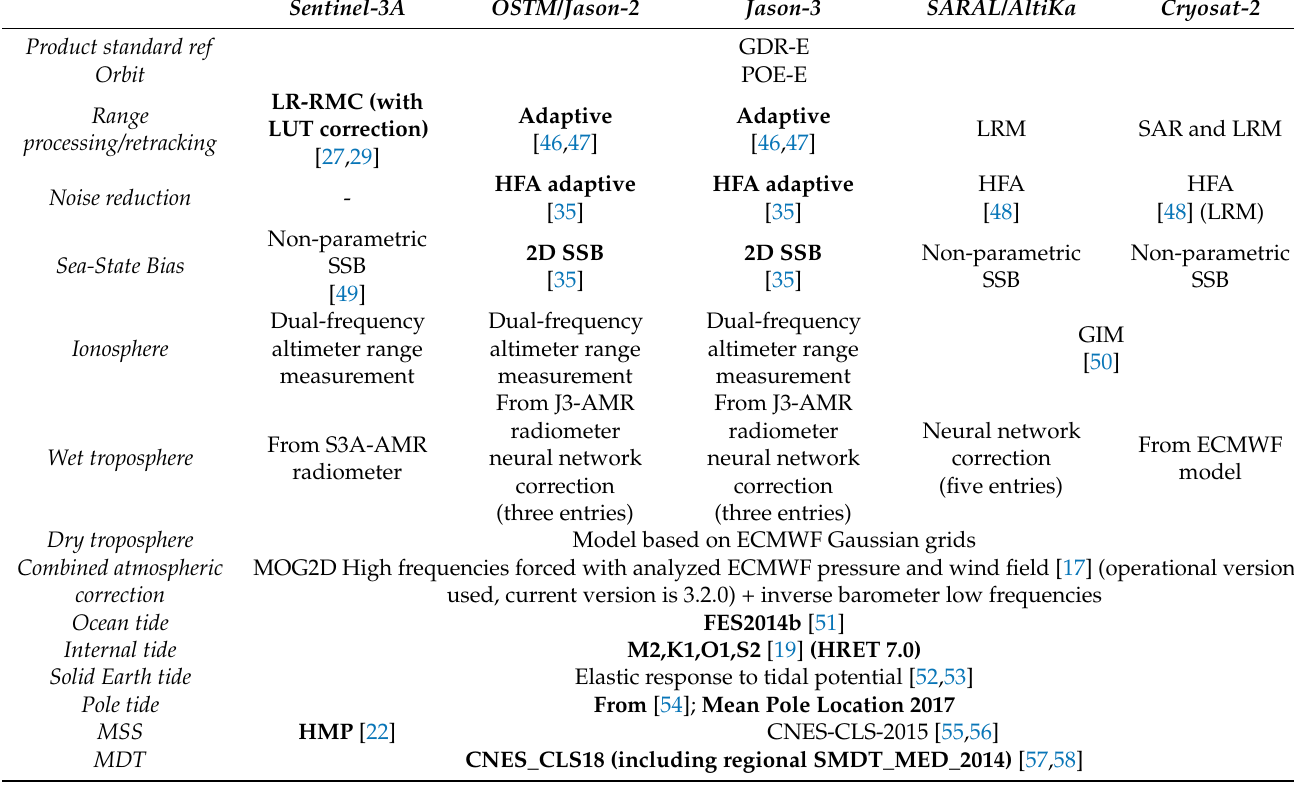
Table 1. Altimeter standards and corrections used for the processing of the different altimeter measurements. Differences with standards applied on the conventional L3 1 Hz products available at the time of the L3 5 Hz production (“DT-2018” standards) are shown in